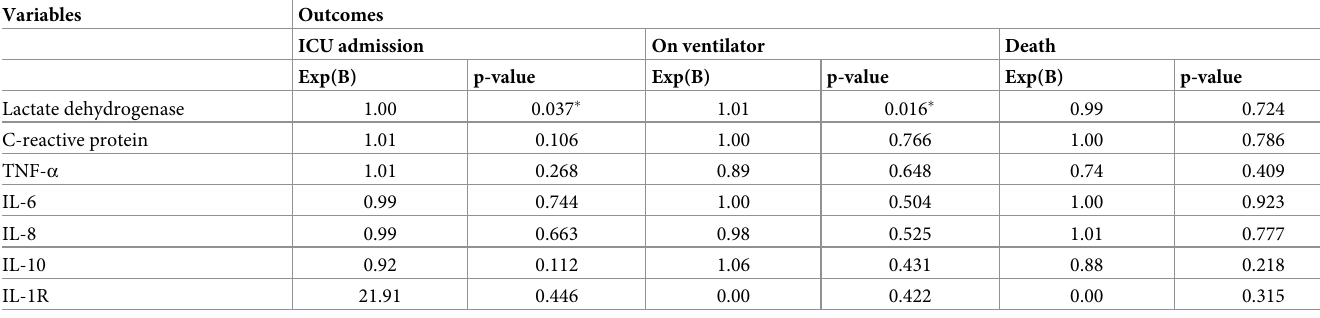
Table 5. Logistic regression for factors associated with COVID-19 outcomes.